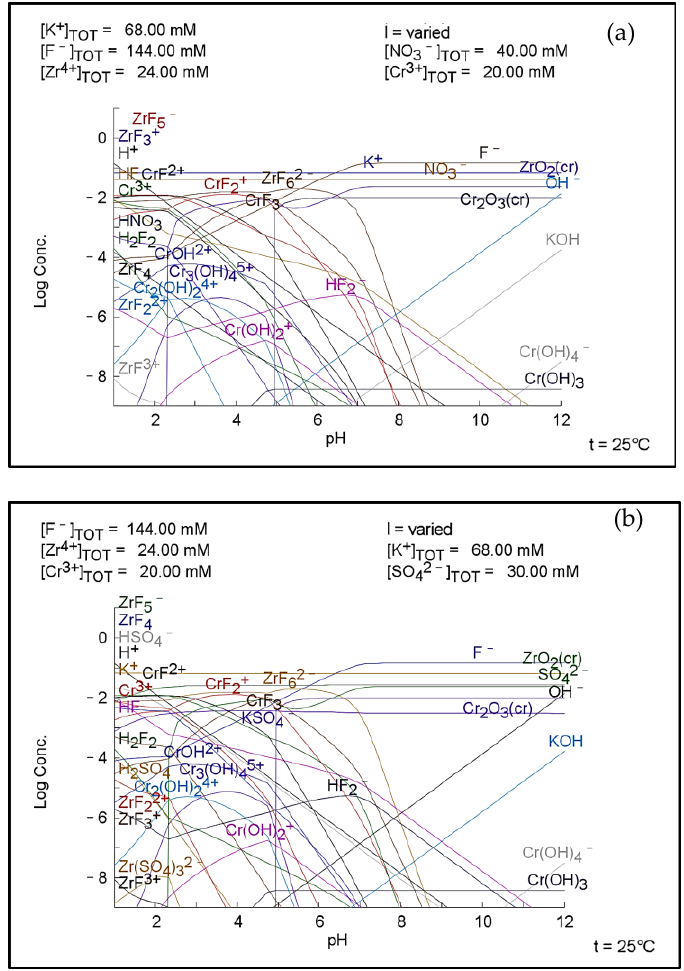
Figure 9. Simulated plots of species concentration relative to pH including ( a ) in the mixture solutions of 0.024 M K 2 ZrF 6 and 0.02 M Cr(NO 3 ) 3 and ( b ) in the mixture solutions of 0.024 M K 2 ZrF 6 and 0.01 M Cr 2 (SO 4 ) 3 at room temperature.